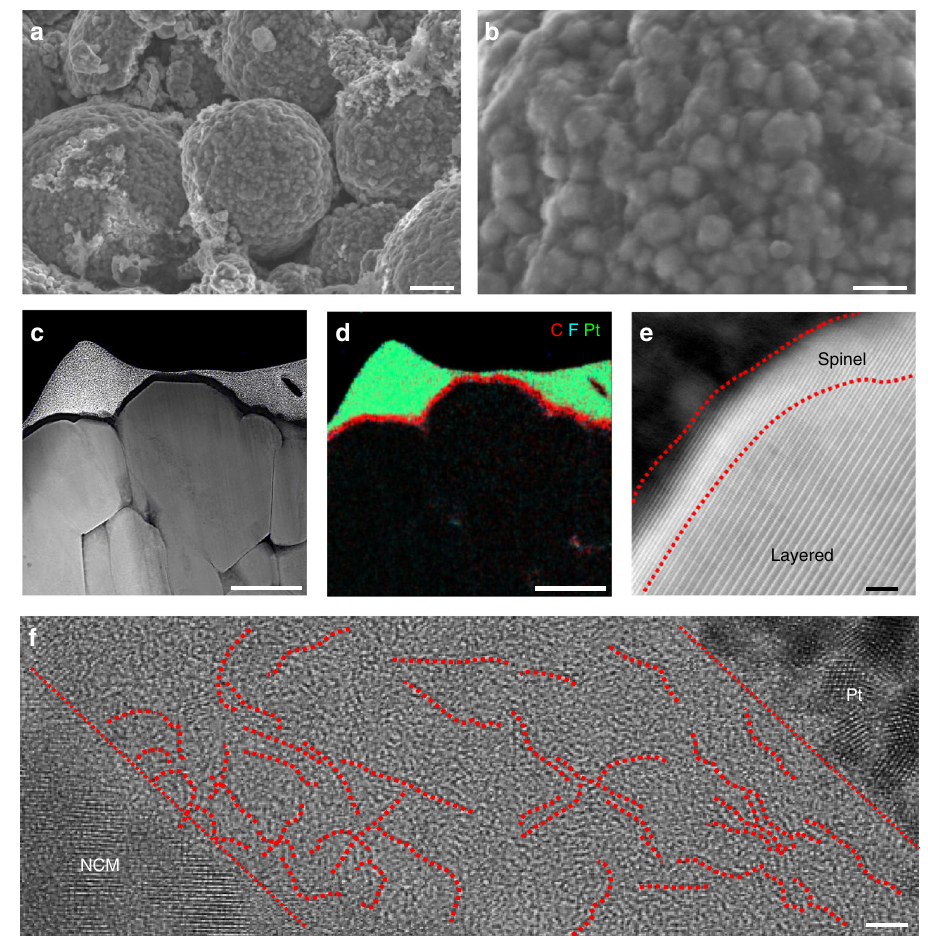
Fig. 6 Characterization of GB-NCM in a full-cell cycled at 60 °C and 5C for 500 cycles. a , b SEM images a low magni fi cations and b high magni fi cations (scale bars, 2 µ m and 500 nm, respectively). c Cross-sectional STEM image (scale bar, 200 nm) and d its EDX elemental mapping with respect to C, F, and Pt (scale bar, 200 nm). e High-resolution STEM image around the surface of GB-NCM (scale bar, 2 nm). f TEM image around the NCM surface (scale bar, 2